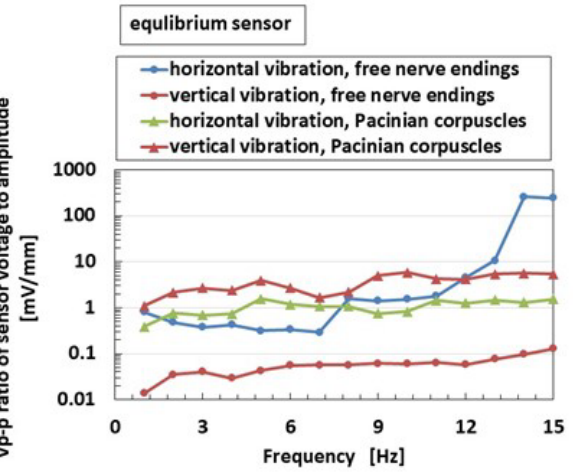
Figure 13. Experimental results of the vibrating equilibrium sensor by a mechanical vibrator.